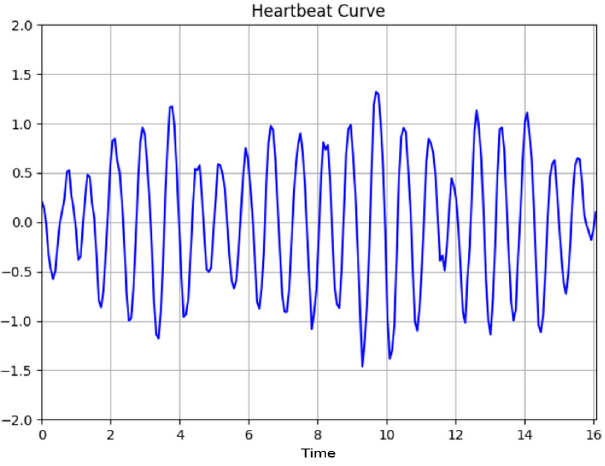
Figure 3. Heartbeat curve in